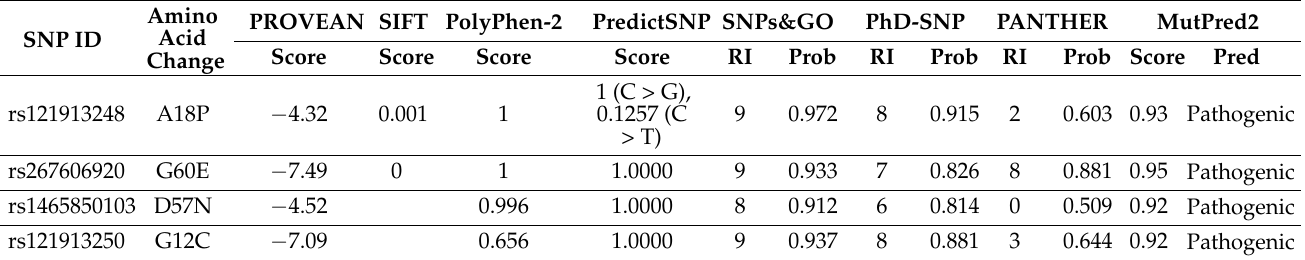
Table 1. High-risk nsSNPs of NRAS predicted using PROVEAN, SIFT, PolyPhen-2, PredictSNP, SNPs&GO, PhD-SNP, PANTHER and